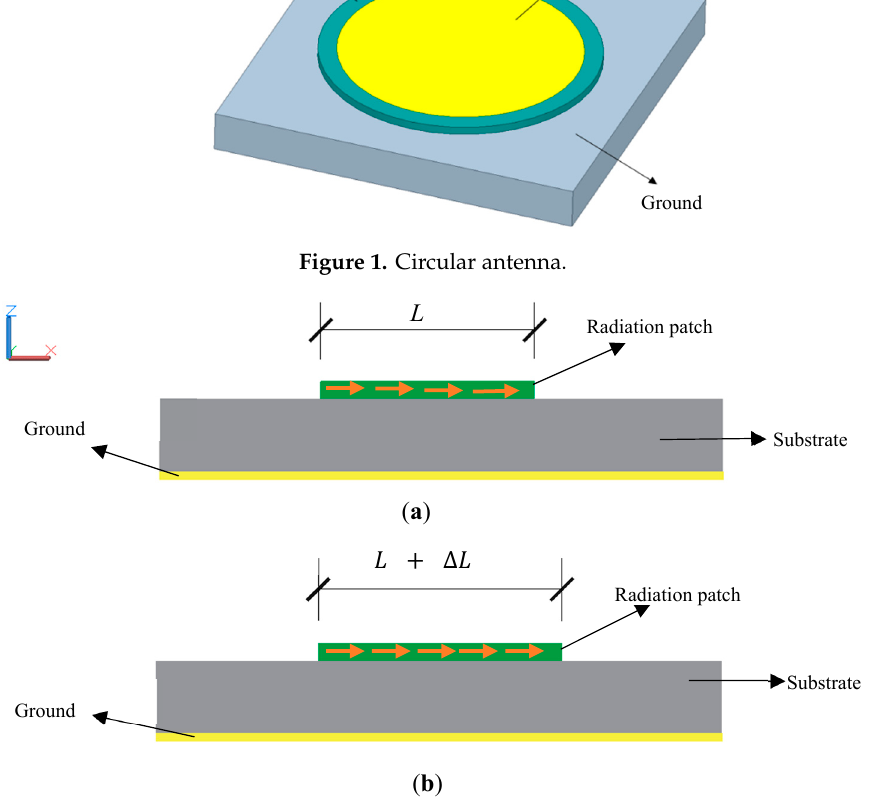
Figure 2. Schematic diagram of a variation in electrical length: ( a ) the initial state of the antenna and ( b ) the deformed state of the